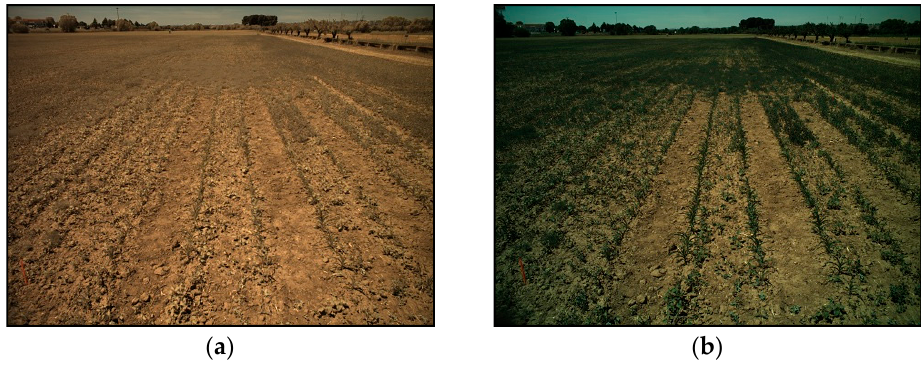
Figure 2. Effect of the UV/IR cutting filtering: ( a ) without filter; ( b ) with filter.